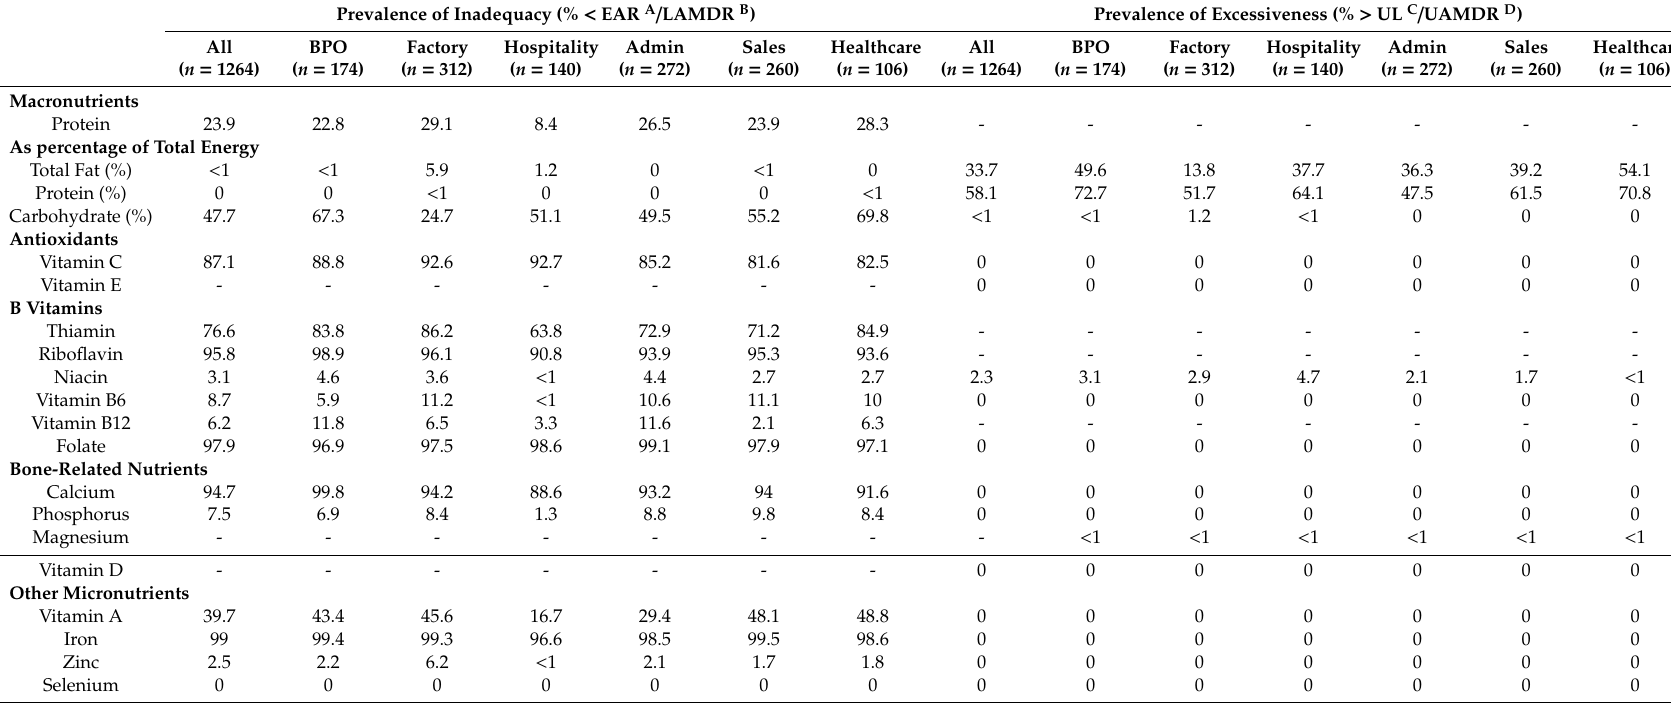
Table 4. Prevalence of inadequate and excessive intake of nutrients by